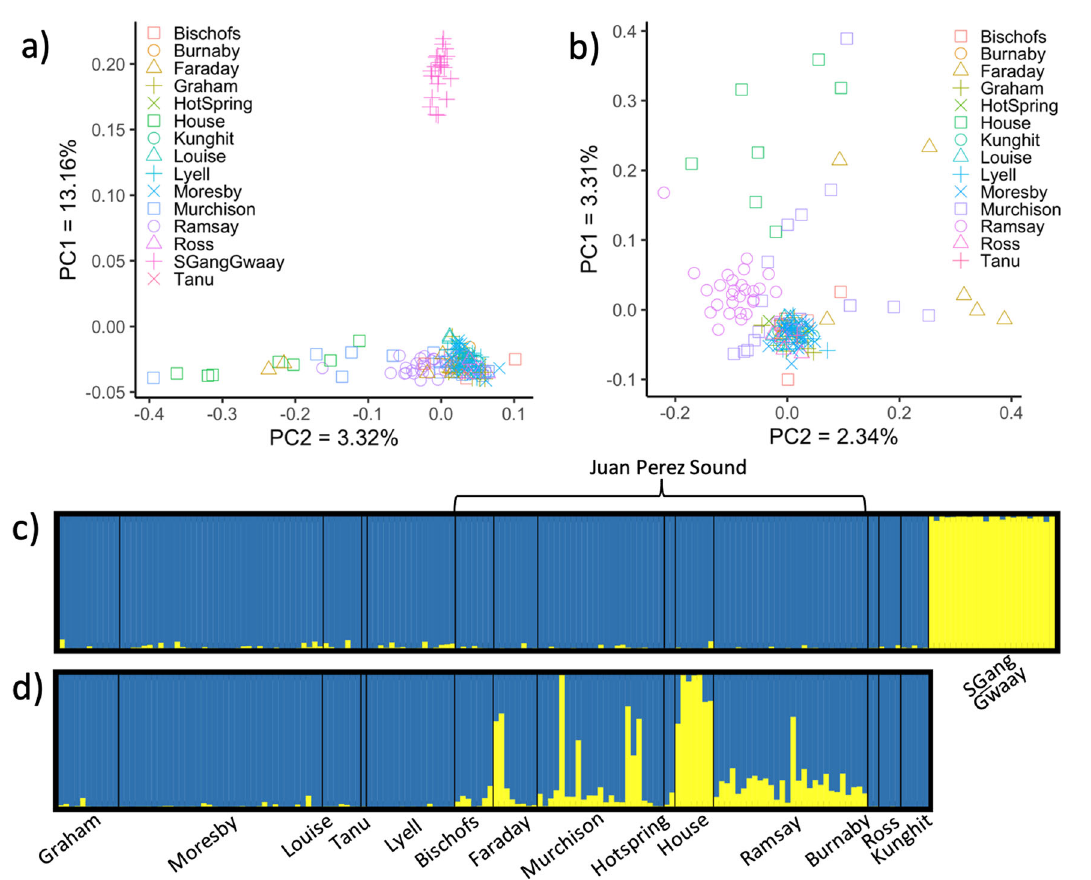
Fig. 2 Genetic clustering and population structure of Sitka black-tailed deer in Haida Gwaii. All analyses were performed using Sitka black-tailed deer genotyped at 12,947 neutral SNPs. a Principal component analysis using all deer genotyped in the study ( n = 181). b Same as ( a ), but with deer from SGang Gwaay removed ( n = 158). c Bayesian clustering using all deer showing the proportion of ancestry of each individual (vertical bar) assigned to inferred populations ( K = 2) that are designated by color. Harvest locations for each deer are listed underneath, structured by island. d same as ( c ), but with deer from SGang Gwaay